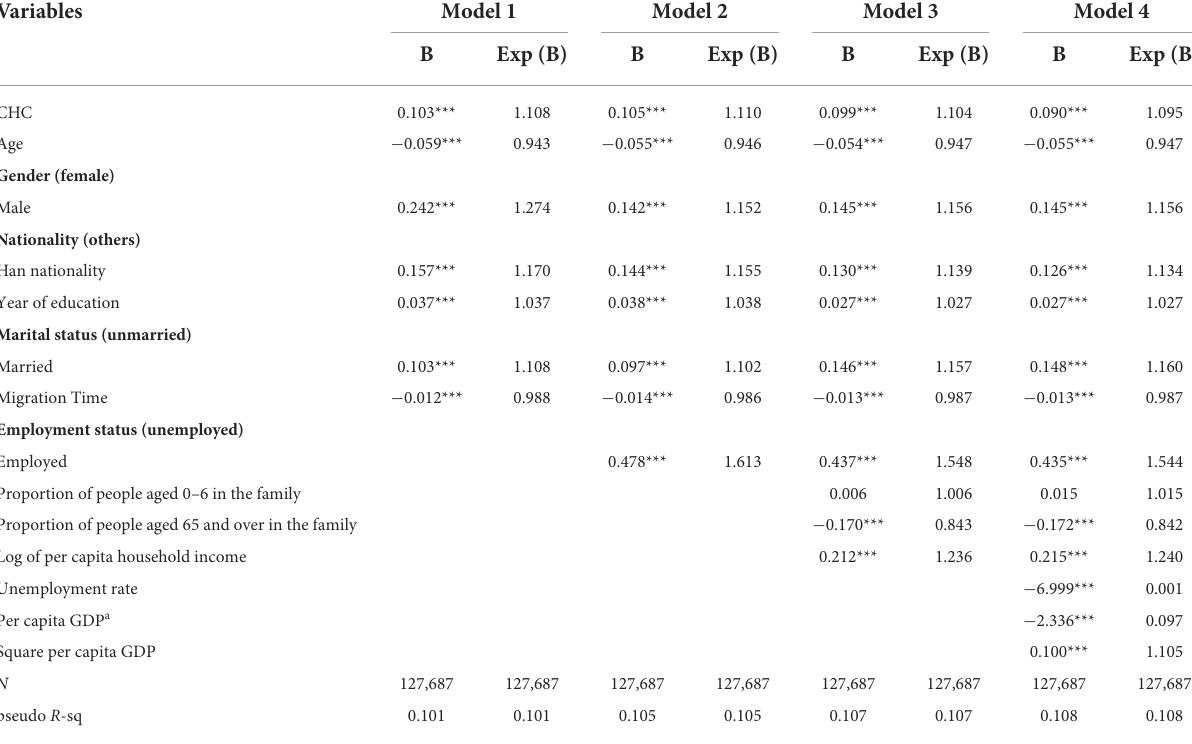
TABLE 4 Logistic regression results of CHCs on SRH of the migrants in China ( N =